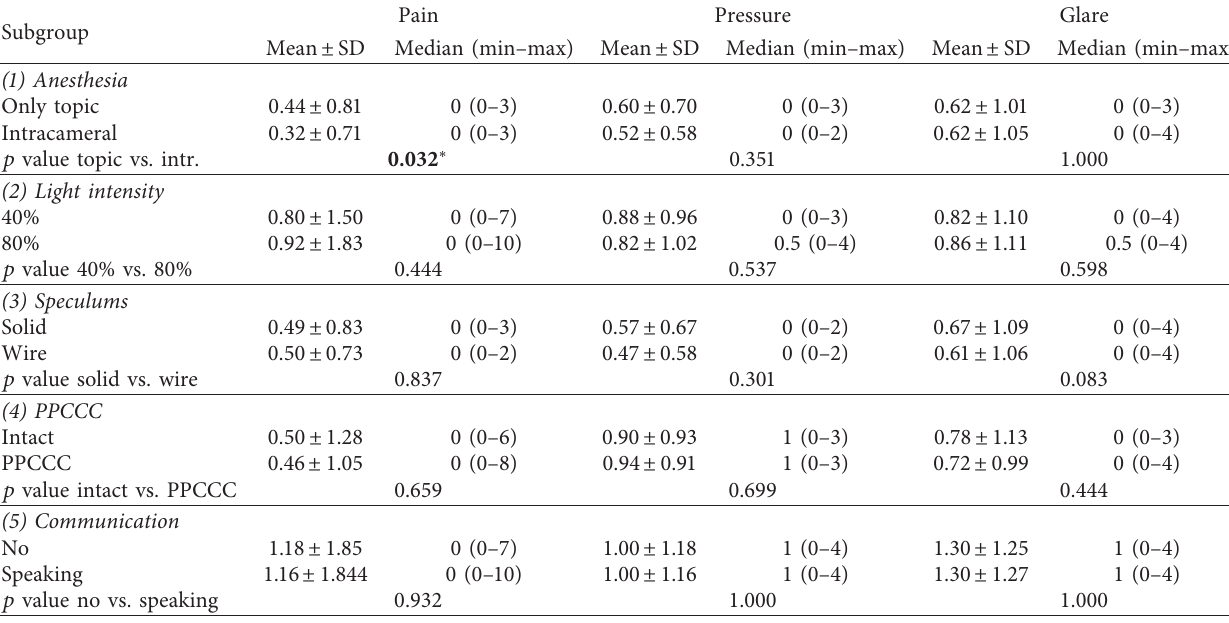
Table 4: Comparison of perception of pain, pressure, and glare between eyes with and without changing parameters of surgery in 5 subgroups: mean ± SD, median (min-max); p values of Wilcoxon signed-rank test. Subgroup